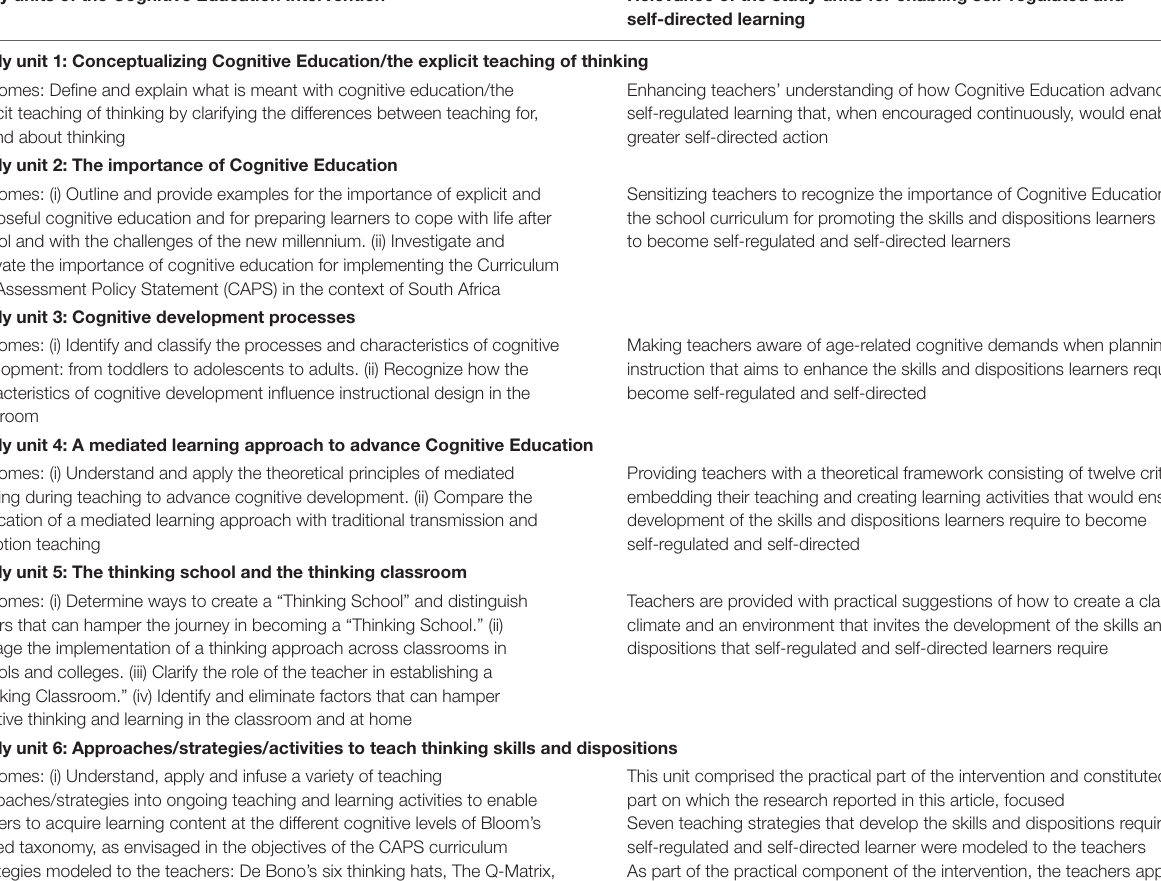
TABLE 1 | Structure of the cognitive education intervention and its relevance for enabling self-regulated and self-directed learning. Study units of the Cognitive Education Intervention Relevance of the study units for enabling self-regulated and self-directed